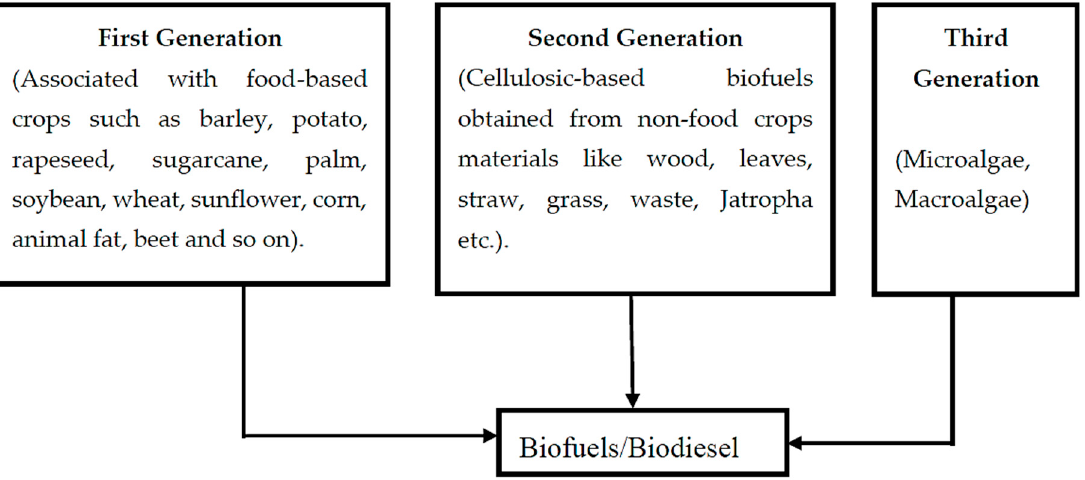
Figure 1. Generation of Biofuels/Biodiesel.